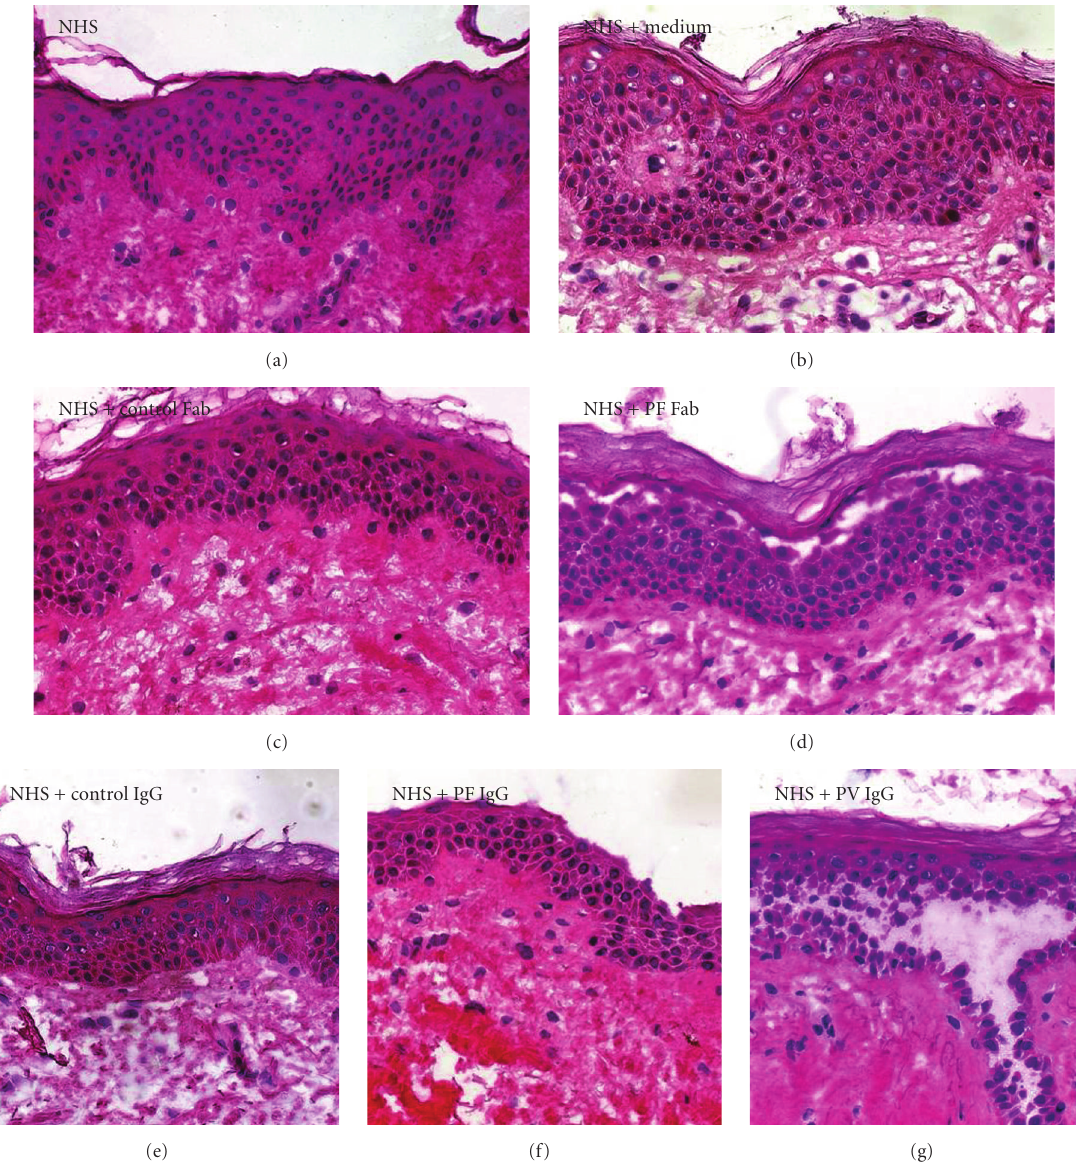
Figure 1: Incubation of normal human skin with pemphigus IgG or Fab fragments leads to suprabasal or subcorneal acantholytic blistering. (a) Normal human skin (NHS) before incubation. Incubation of NHS for 24 hours in (b) medium only or in medium with added (c) control Fab fragments or (e) control IgG leads to limited spongiosis of the epidermis. Incubation of NHS in medium with added (d) PF Fab fragments and (f) PF IgG induces a subcorneal split. Incubation of NHS in medium with (g) PV IgG induces suprabasal